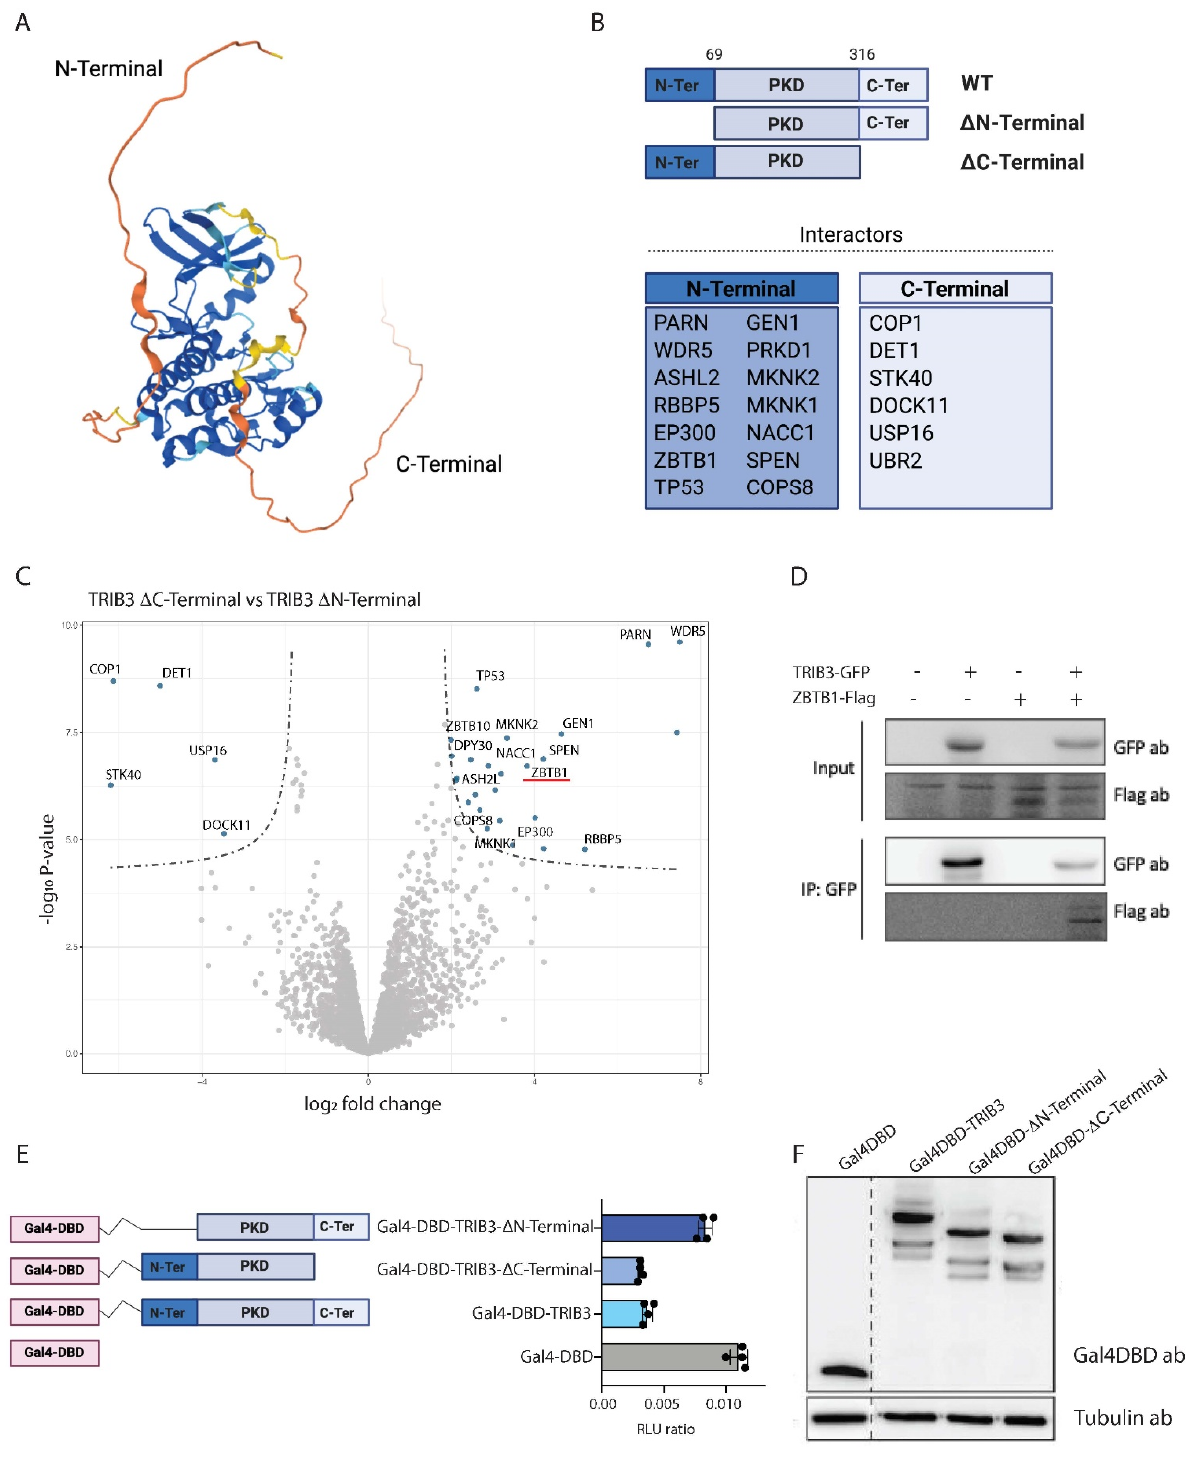
Figure 2. Contribution of TRIB3 domains to its interactome and function. ( A ) Human TRIB3 structure prediction by AlphaFold. Colors represent pLDDT score (blue: very high confidence, light blue: confident, yellow: low and orange: very low or unstructured). ( B ) Schematic representation of TRIB3 mutants and specific interactors lost when the indicated domain was removed. ( C ) Volcano plot showing interaction of the N-terminal and C-terminal domains of TRIB3 in HEK293T cells. ( D ) Co-immunoprecipitation assay of TRIB3-GFP and ZBTB1-Flag in HEK293T cells. ( E ) Gal4 reporter assay of Gal4-DBD, Gal4-TRIB3, Gal4-TRIB3-ΔN-terminal and Gal4-TRIB3-ΔC-terminal in Hek293T cells. Data is normalized using Renilla luciferase. ( F ) Western blot using Gal4DBD and tubulin antibodies showing similar expression of the constructs used for the Gal4 reporter